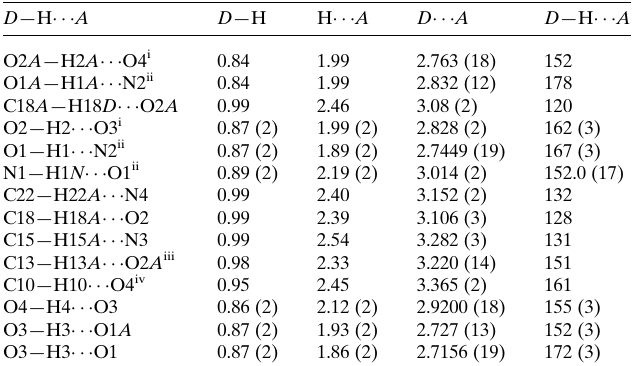
Table 1 Hydrogen-bond geometry (A˚ , (cid:3) ).